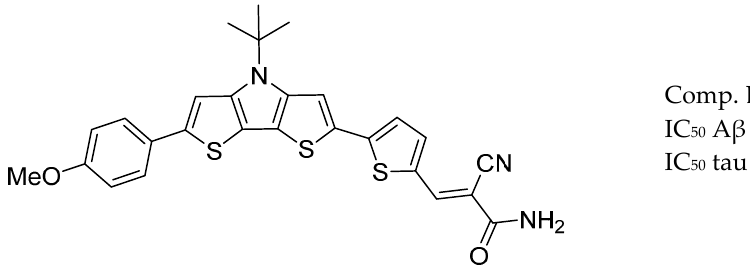
Figure 16. Oligo heteroaromatic hybrid with BACE-1 and GSK-3 β inhibitory activity from [173].